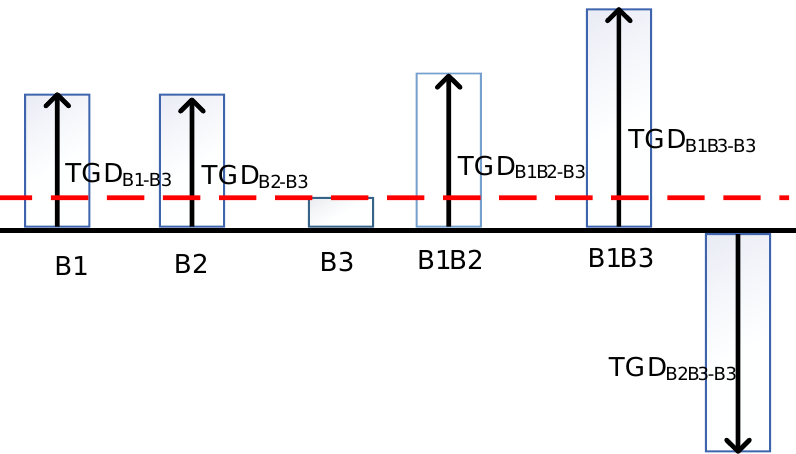
group delay) or DCB (differential code bias) should be utilized to be corrected, as shown in Figure 1. The particular corrective techniques are discussed in [15,16]. The precise corrected products of the Chinese Academy of Sciences’ Institute of Geodesy and Geophysics (IGG), which includes the GPS, GLONASS, Galileo, BDS, and QZSS, provided the DCB correction for this investigation with an accuracy range of 0.2 ns to 0.6 ns [17].